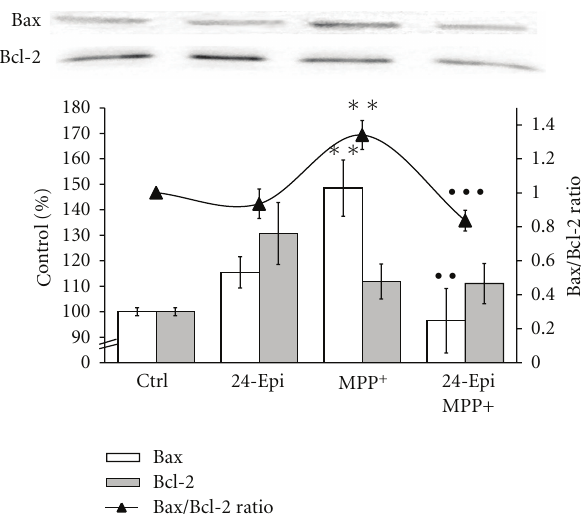
Figure 8: E ff ect of 24-Epi on the Bax/Bcl-2 ratio in neuronal PC12 cells. Cells were pretreated with 24-Epi or vehicle (Ctrl) for 3 h. Then, they were treated or not with MPP + for 24h. Bax and Bcl- 2 protein expression levels were quantified and the Bax/Bcl-2 ratio was determined for each treatment (- -). Pretreatment with 24-Epi (cid:3) alone did not modulate the Bax/Bcl-2 ratio (24-Epi). In contrast, the Bax/Bcl-2 ratio increased upon treatment with MPP + while pretreatment with 24-Epi (24-Epi + MPP + ) significantly prevented this increment. The data are expressed as percentages of values in untreated control cells and are means ± S.E.M. n = 3. ∗∗ P < . 01 versus Ctrl, •• P < . 01 versus MPP + , and ••• P < . 001 versus MPP +